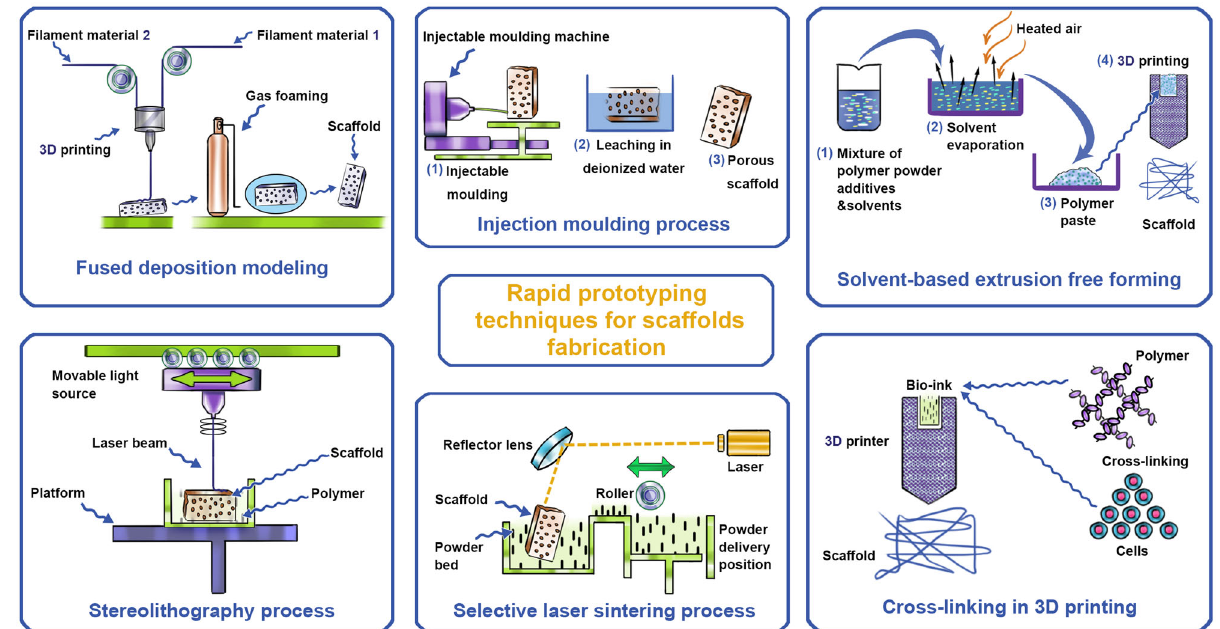
Fig. 5 Schematic illustration of rapid prototyping techniques in scaffold